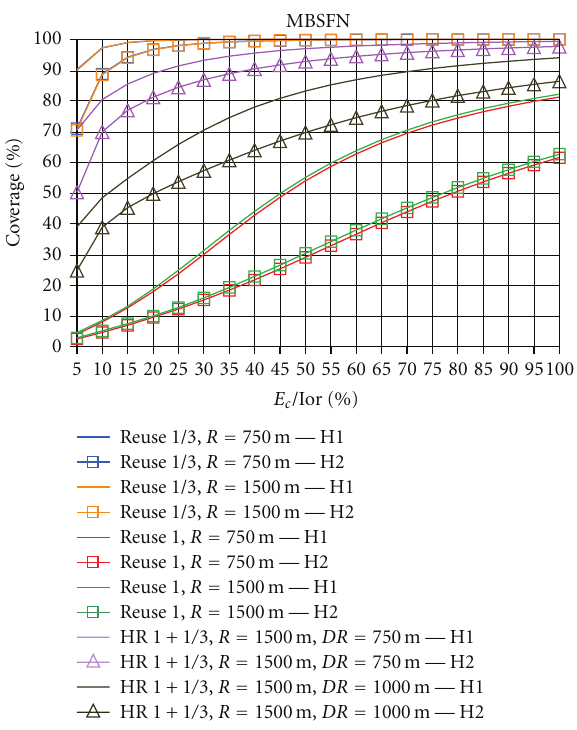
Figure 13: Average coverage (%) versus E c /Ior (%), of MBSFN.